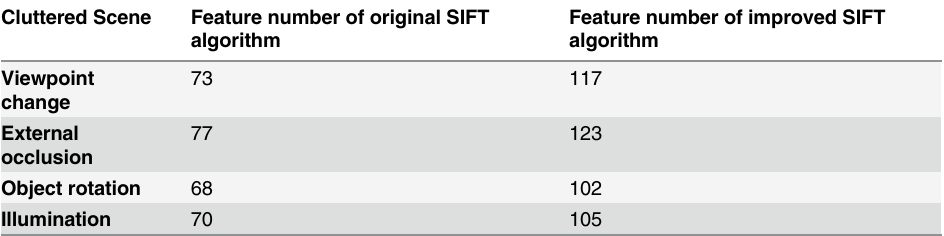
Table 2. Comparison of the Feature Number for the Improved SIFT and the Original